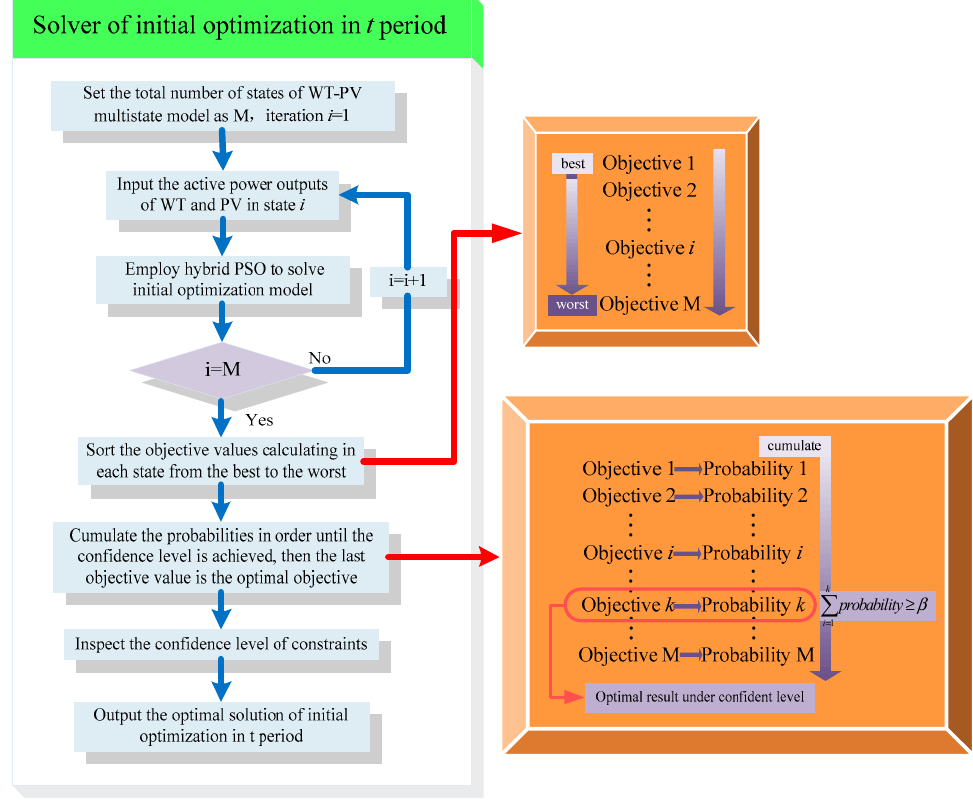
Figure 3. The flow chart of chance constrained programming